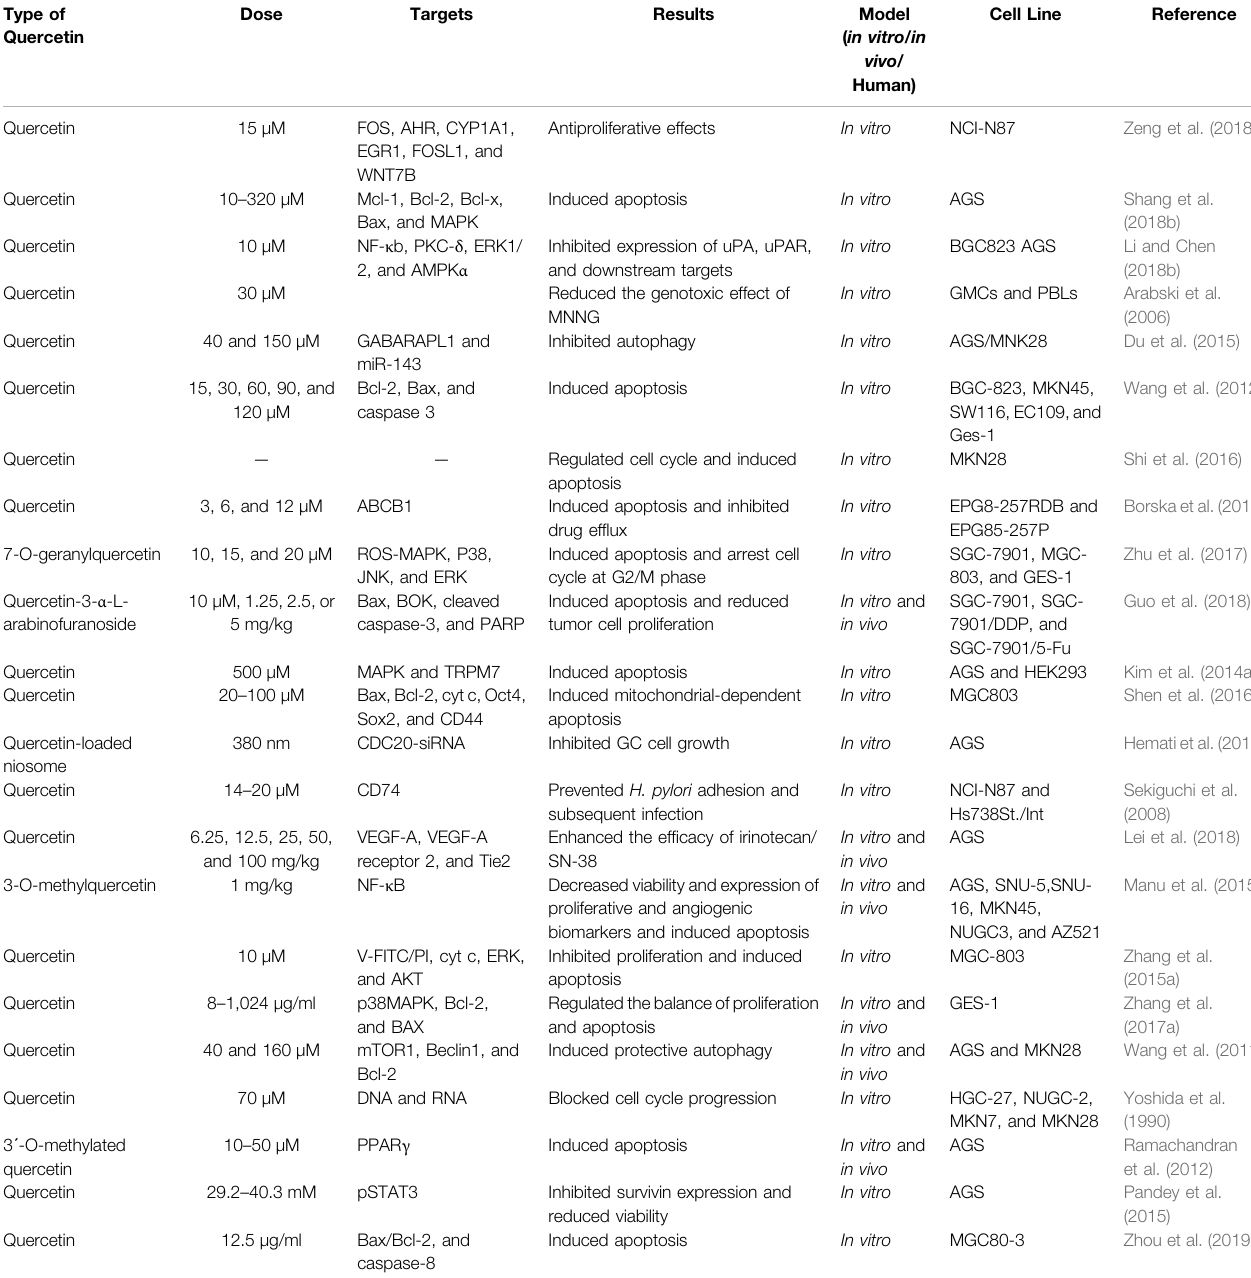
TABLE 2 | Studies on the therapeutic effects of quercetin in gastric